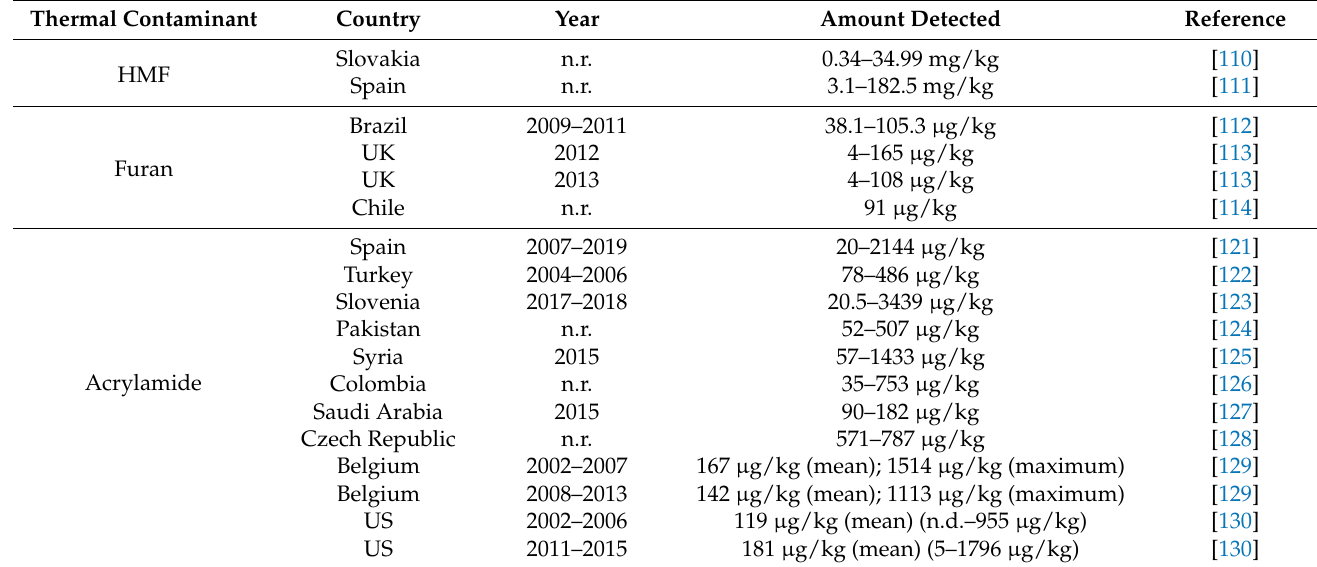
Table 4. Content of 5-hydroxymethyl furfural (HMF), furan, and acrylamide detected in biscuits in different national surveys. Thermal